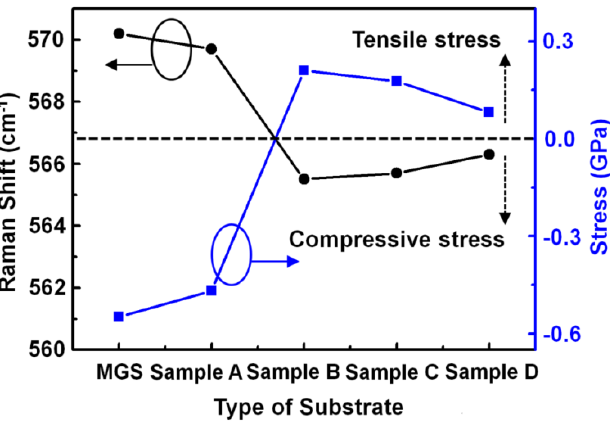
Figure 7. Residual stress and its corresponding E 2 Raman shift for samples MGS, A, B, C, and D.